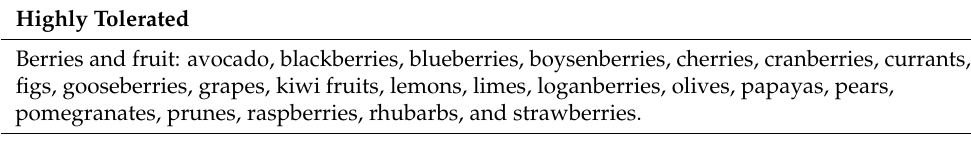
Table 1. Guidelines for berries, fruit, legumes, and vegetable ingestion according to a starch- and sucrose-reduced (SSRD)